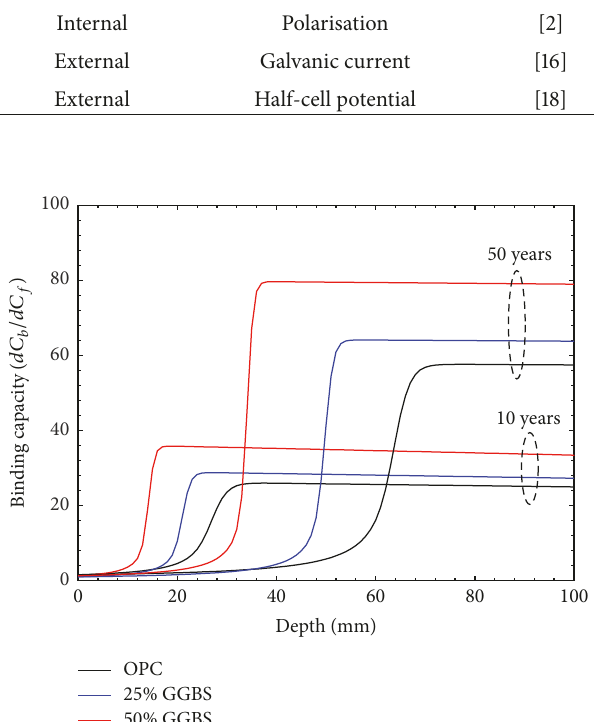
Figure 5: Distribution of binding capacity along chloride penetra- tion with